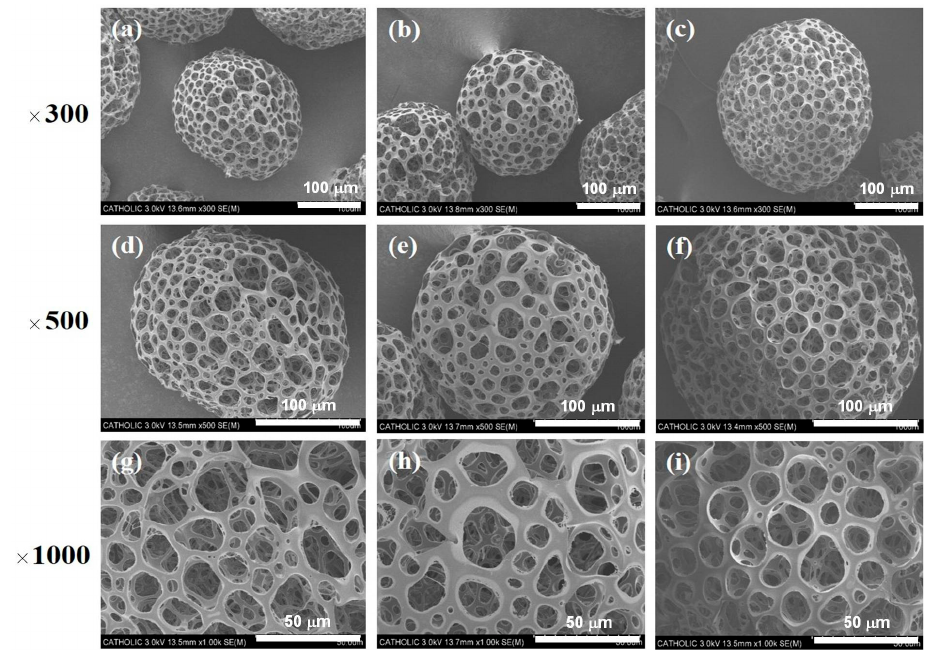
Figure 1. SEM images of porous microspheres (PMSs) ( a , d , g ), simvastatin (SIM) (1 mM)/PMSs ( b , e , h ), and SIM (5 mM)/PMSs ( c , f , i ).